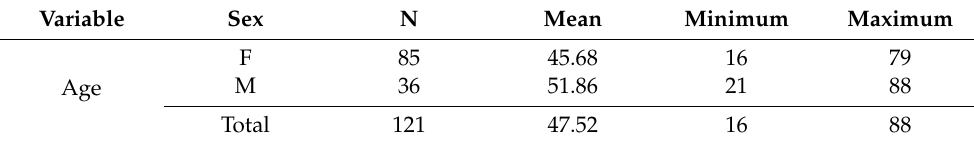
Table 1. Patient demographics.